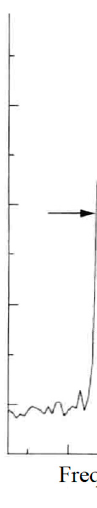
Figure 19. Oscillating spectrum of orthogonally polarized dual-frequency Nd:YAG laser [28] .